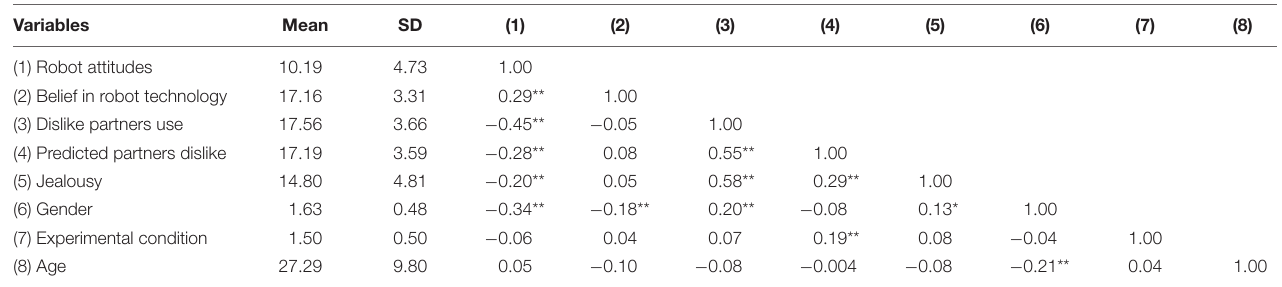
TABLE 1 | Descriptive Statistics and pairwise